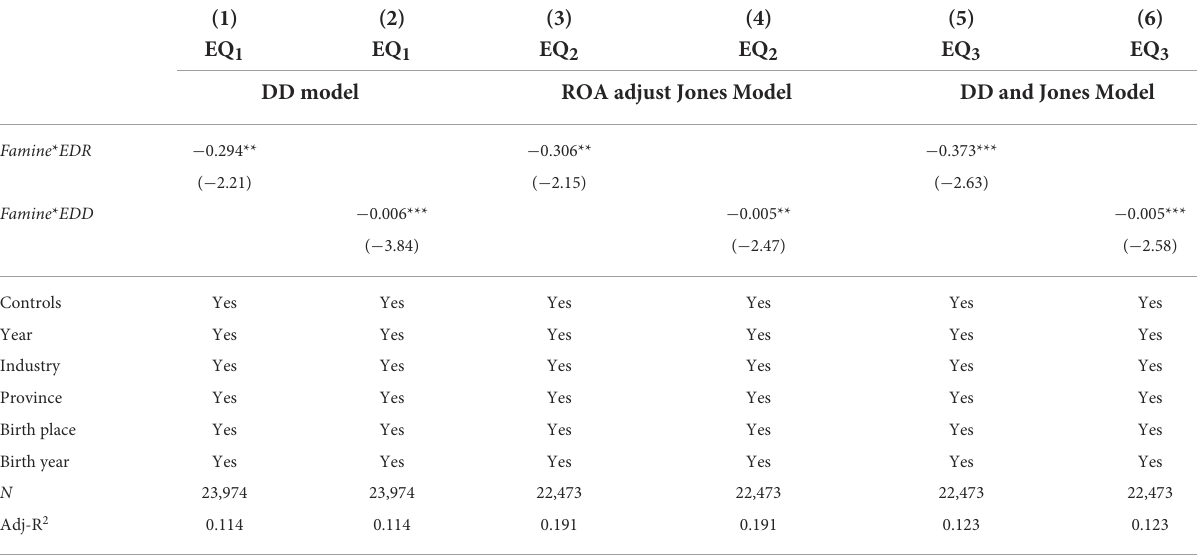
TABLE 10 CEOs’ famine experience and the quality of corporate earnings—sensitivity test for the proxies of earnings